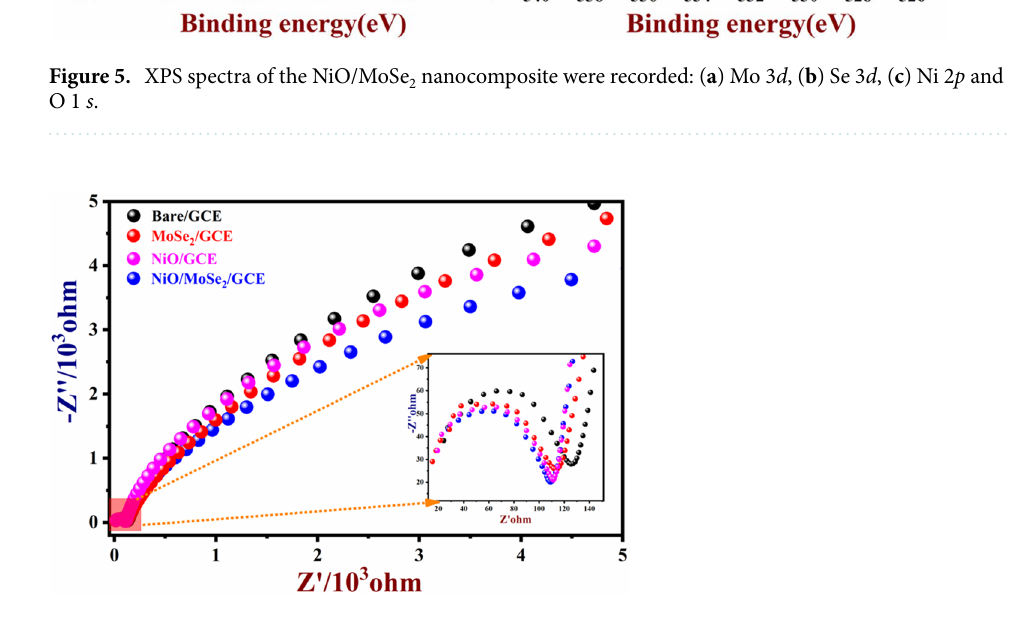
Figure 6. Typical Nyquist plots of NiO/MoSe 2 /GCE, NiO/GCE, MoSe 2 /GCE and bare/GCE were recorded in 0.1 M KCl containing 5 mM [Fe(CN) 6 ] 3−/4− in the frequency range from 0.1 Hz to 1000 kHz (inset is the enlarged view of high frequency